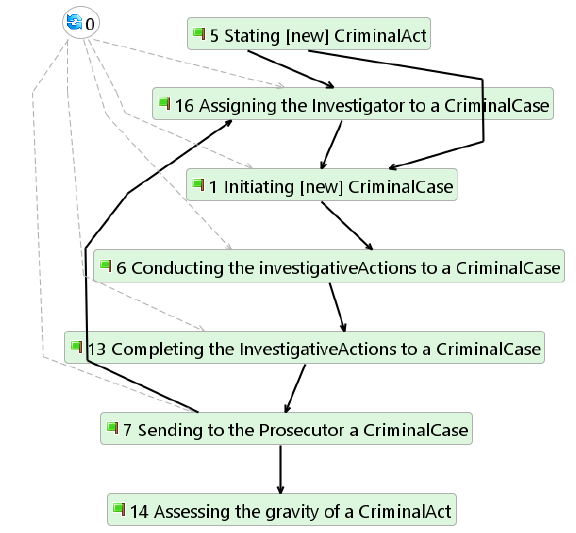
Fig. 4. The TFM obtained after